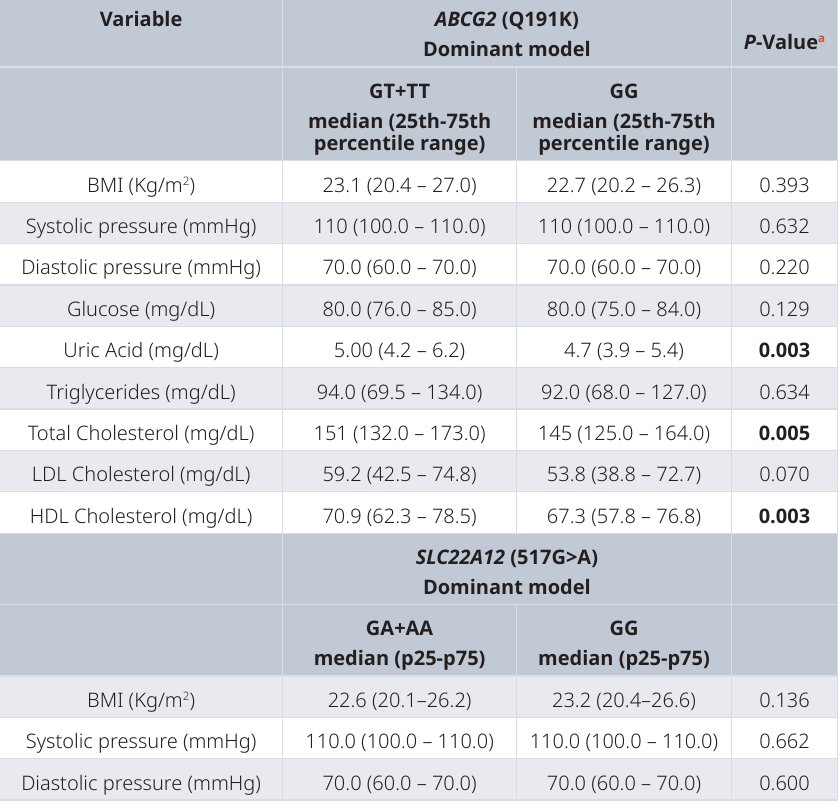
Table 3. Analysis of variables by genotype for the ABCG2 (Q191K), SLC22A12 (517G>A), and XDH (518T>C) genetic polymorphisms.